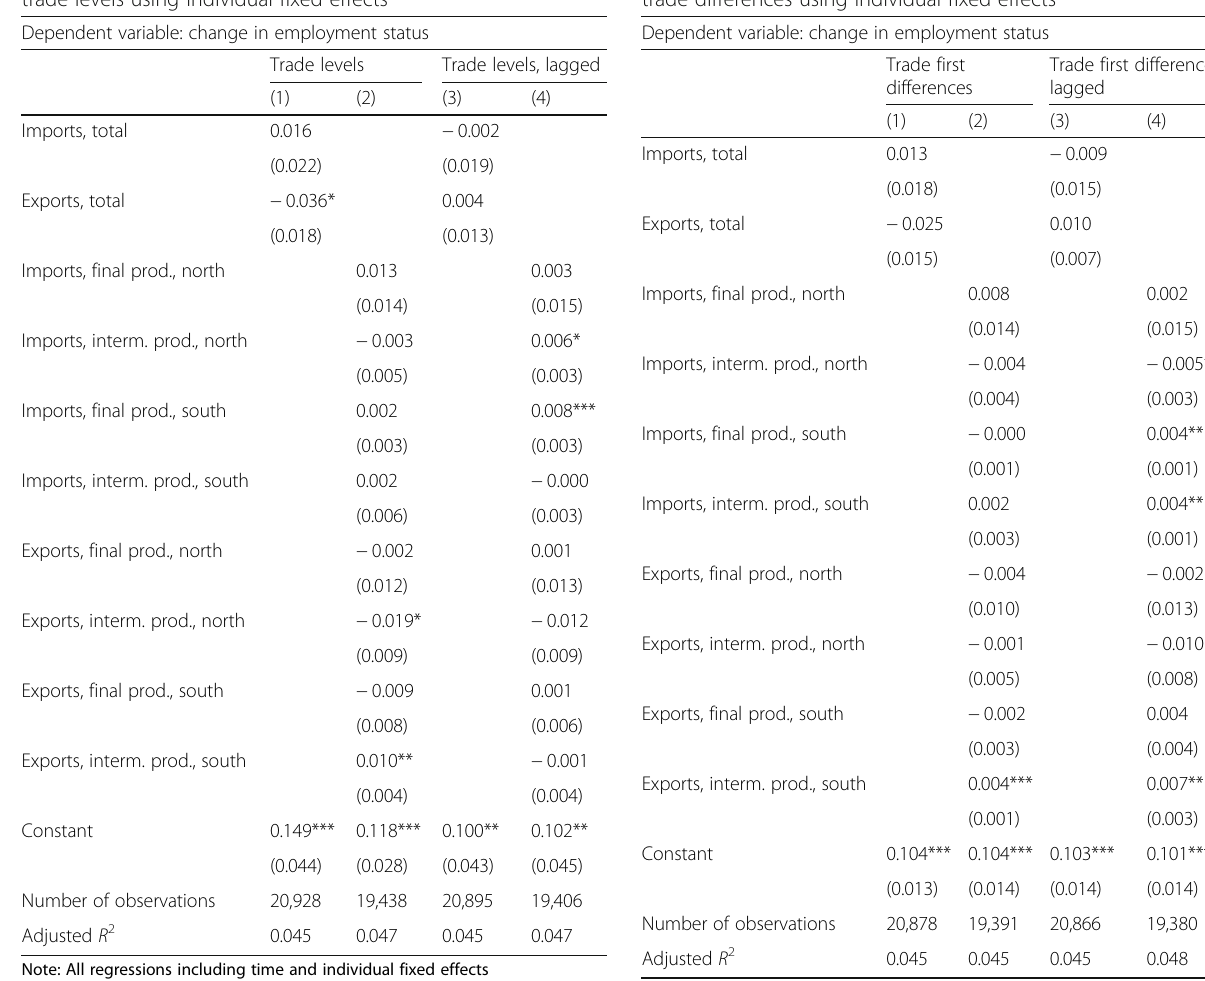
Table 4 Linear regressions of changes in employment status